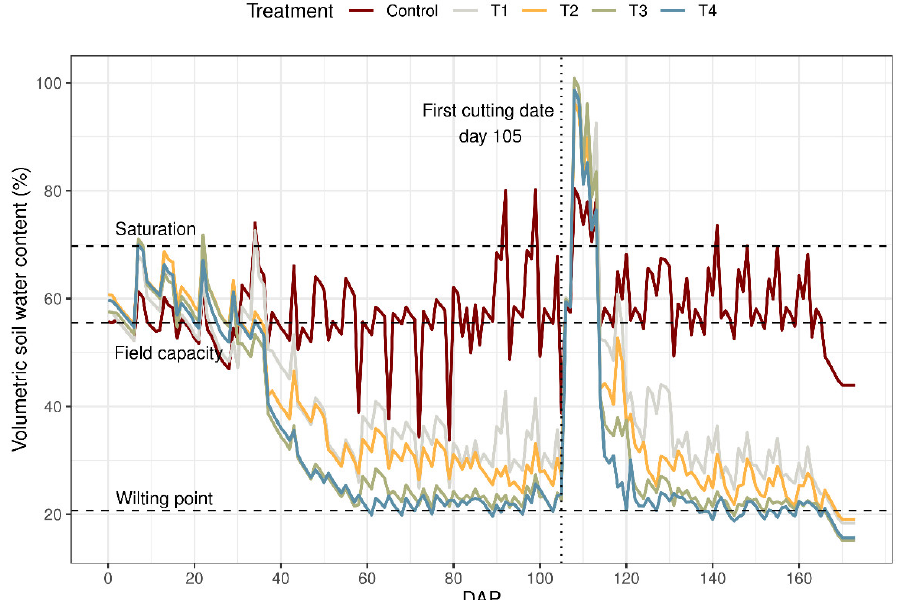
Figure 1. Volumetric soil water content (%) across treatments as a function of days after planting during the experimental period. The values are an average of four replications. The planting date of the ryegrass ( Lolium perenne ) was 15 August 2012, and the first cut date was 28 November 2012; the second cycle was 28 November 2012–30 January 2013. Treatments: Control: non-stressed treatment, T1: moderate–low water stress treatment, T2: moderate–high water stress treatment, T3: medium